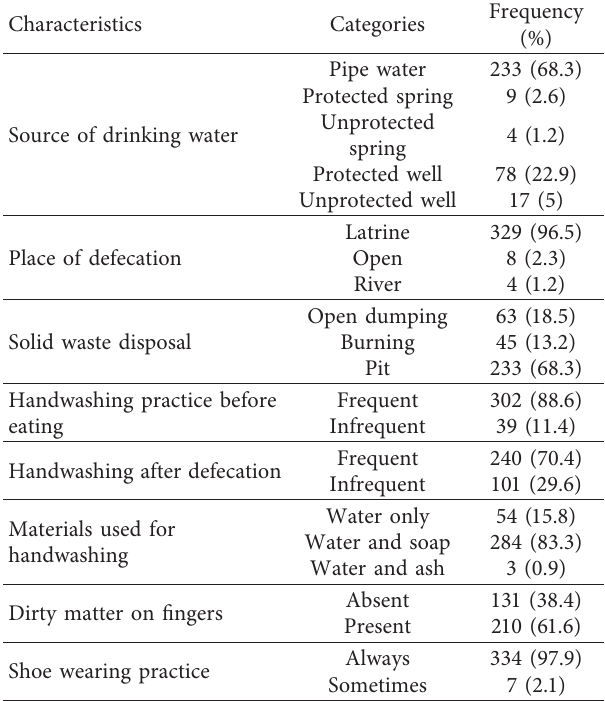
Table 2: Environmental characteristics of primary school children in Kutaber district, Northeast Ethiopia, 2019 ( n � 341). Characteristics